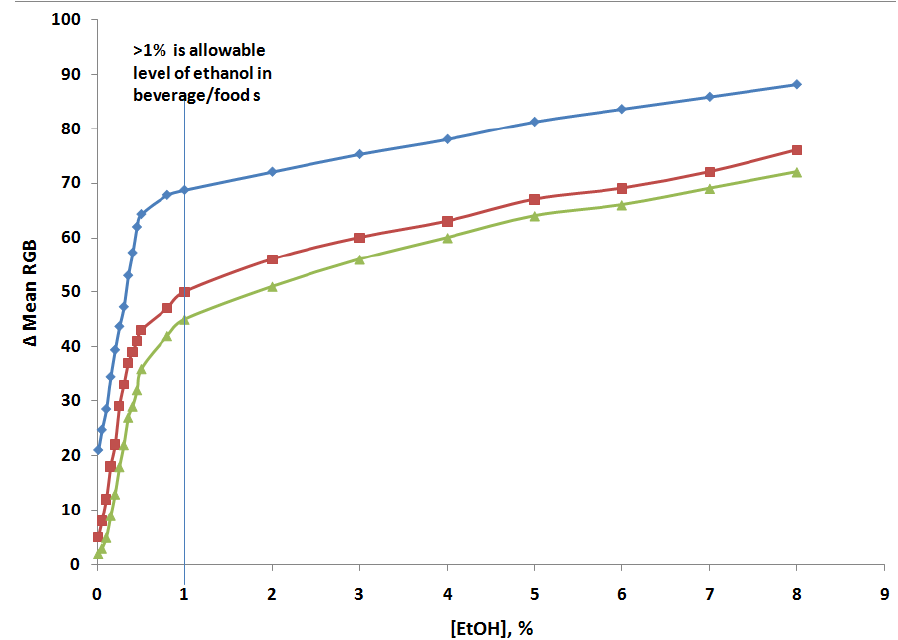
Figure 3. Calibration curves recorded at AOX/PANI biosensors using Δ mean RGB values in 0.1 M phosphate buffer at pH 6.0, with 0.01% (▲), 0.05% (■) and 0.1% (♦) AOX on PANI film.